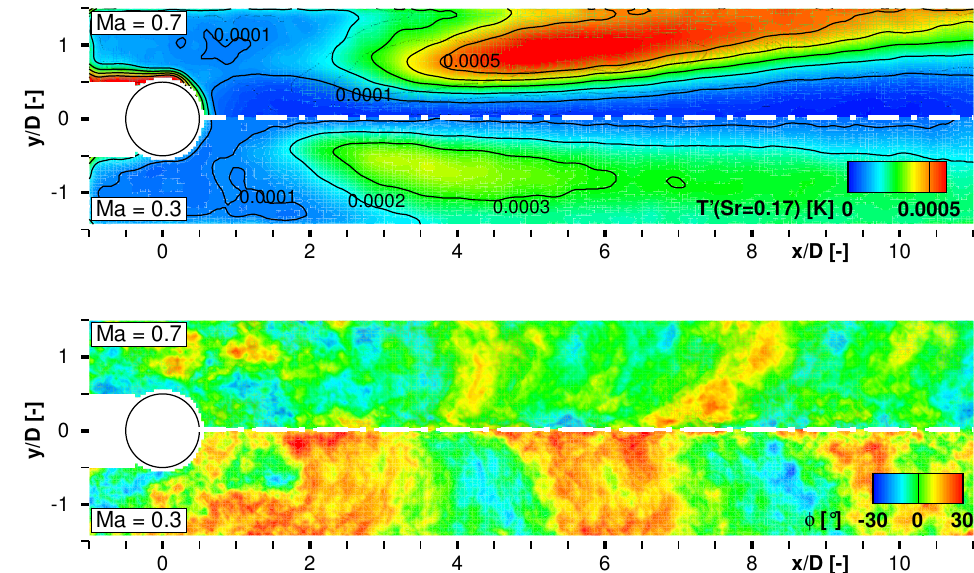
Figure 9. Local temperature fluctuation amplitudes ( top ) and phase angle φ ( bottom ) at Sr = 0.17 compared for Ma ∞ = 0.3 and Ma ∞ =